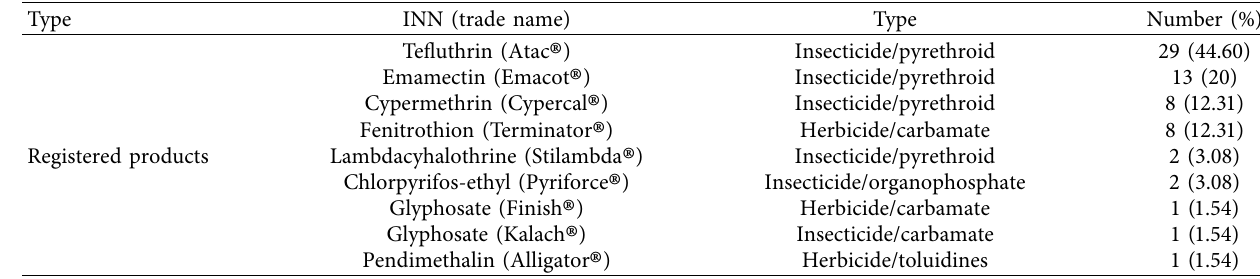
Table 3: List of trade names of pesticides used by growers.